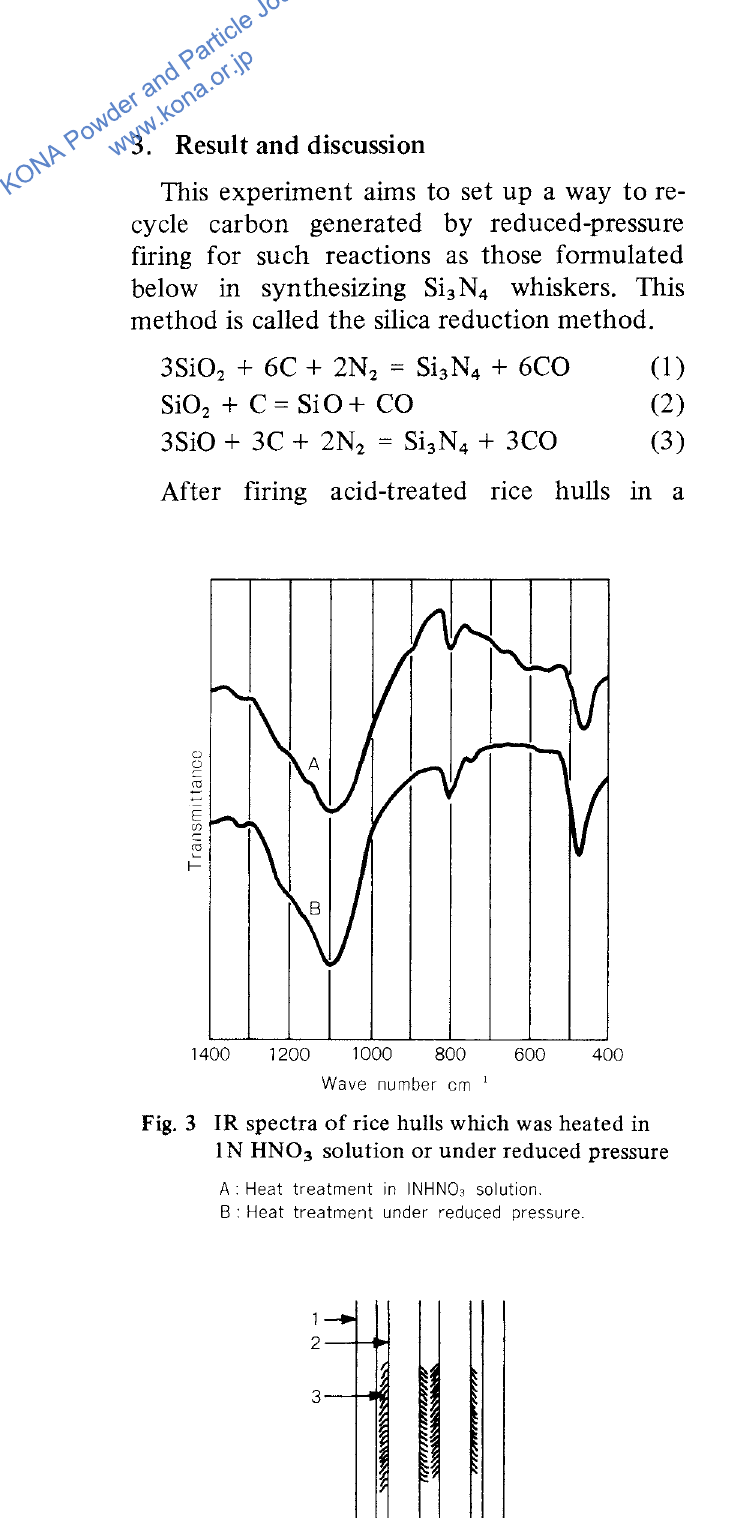
Fig. 5 X-ray diffraction pattern of whiskers